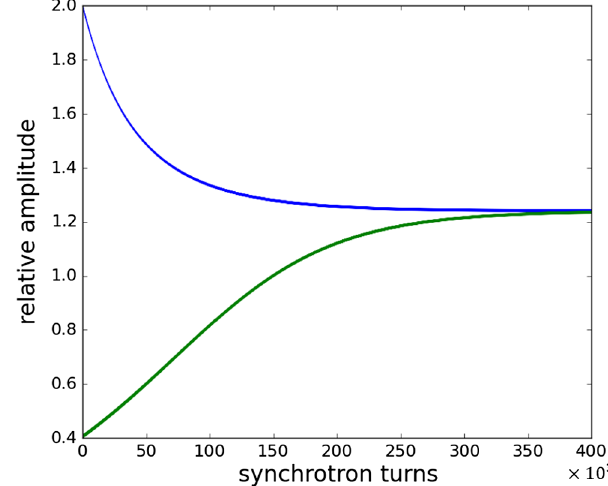
FIG. 2. Evolution of the relative amplitude of synchrotron oscillations under the influence of the friction force shown in Fig. 1. The oscillations of the ion with initial amplitude j 0 ¼ 0 . 4 are getting excited (the green line), and the oscillations of the ion with j 0 ¼ 2 are getting damped (the blue line). Both ions reach a nonzero equilibrium oscillations amplitude in approximately 4 × 10 5 synchrotron